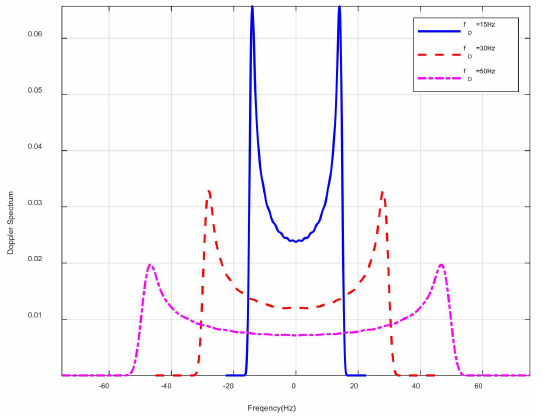
Figure 1. The effect of f D on Doppler